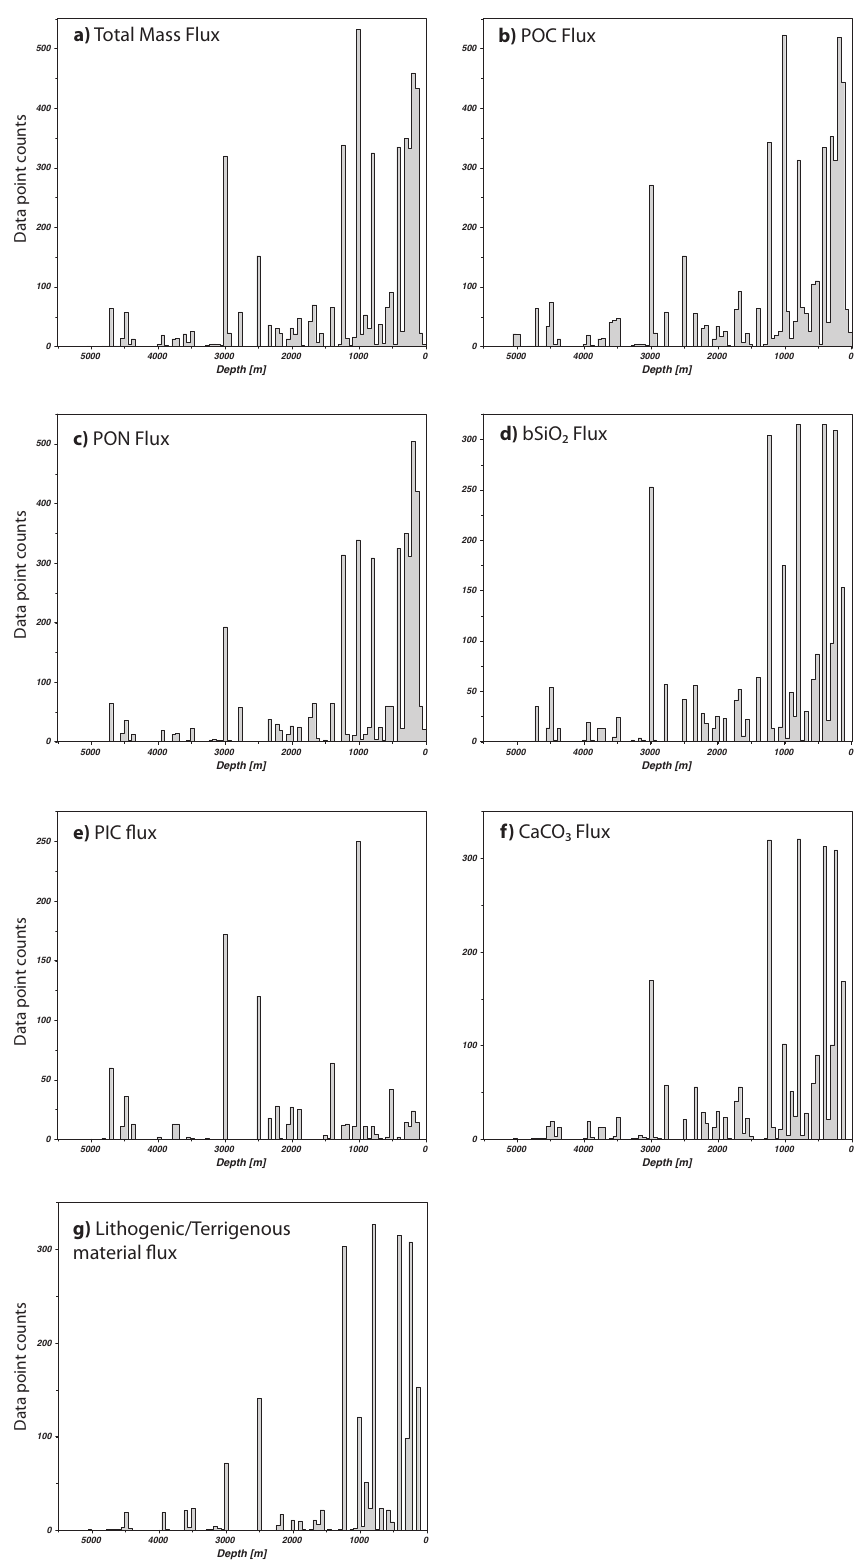
Figure 4. Data points available per depth; (a) total mass flux, (b) POC flux, (c) PON flux, (d) bSiO 2 flux, (e) PIC flux, (f) CaCO 3 flux, and (g) lithogenic / terrigenous material